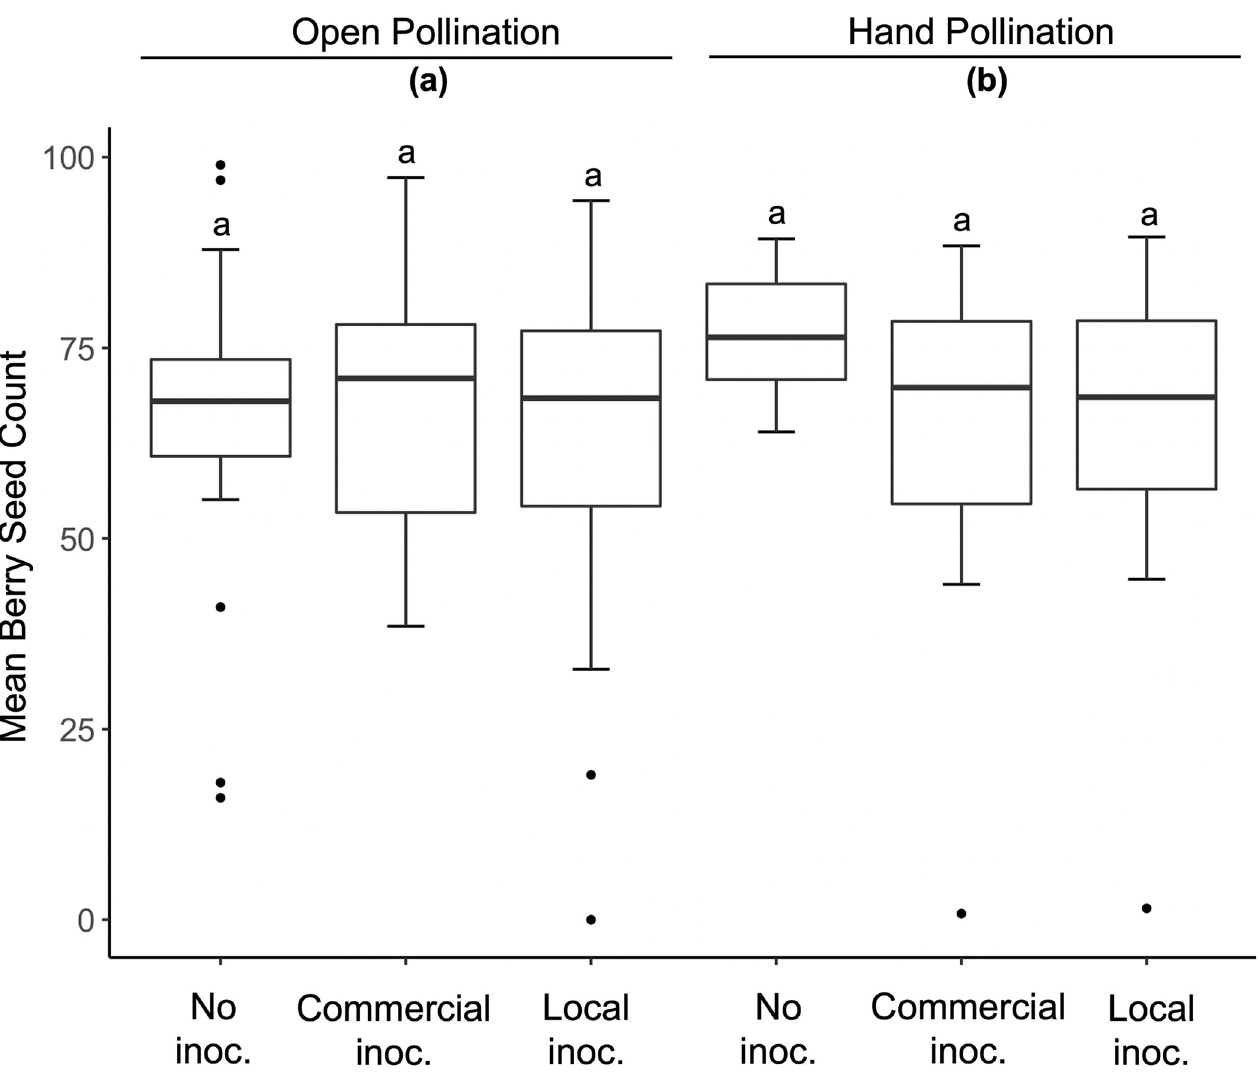
Fig 4. The mean individual berry seed counts for the non-inoculated control, commercial inoculum, and local soil in 2019. Results were analyzed using a Poisson-distributed generalized linear mixed effects model. Letters denote differences among treatment groups using R package